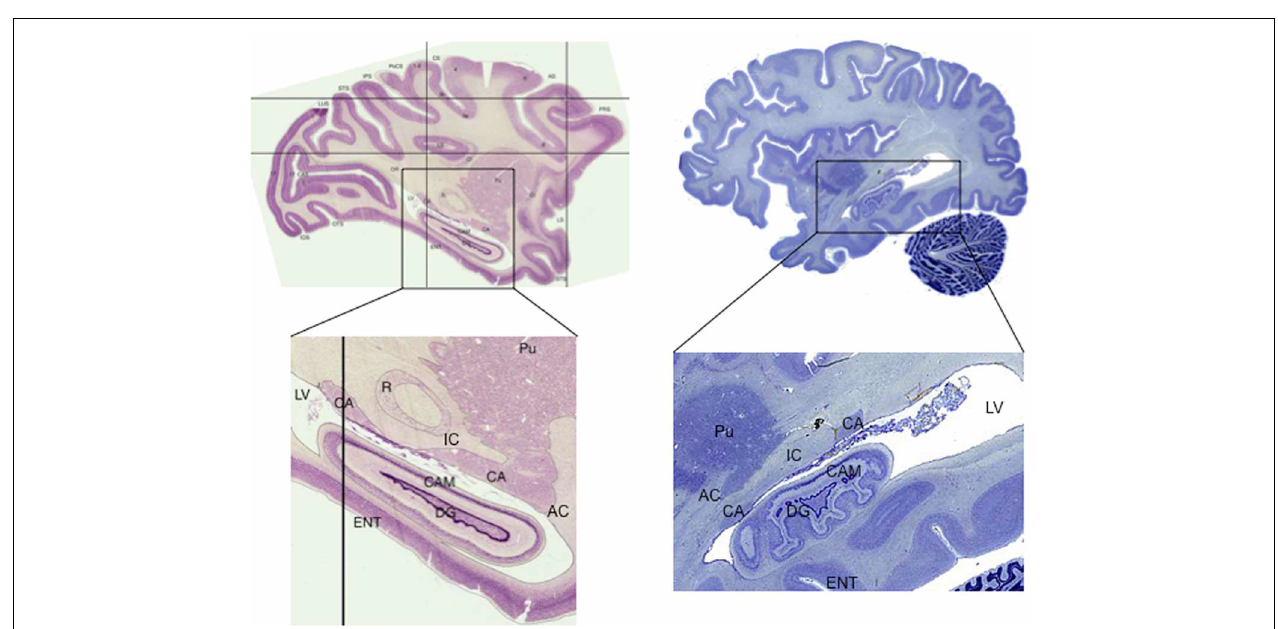
FIGURE 2 | Sagittal sections showing the tail of the caudate in macaque monkey ( Macaca mulatta ) and human. Note the narrow width of the structure, how it follows along the lateral ventricle, and how it passes adjacent to the hippocampus. Macaque images from BrainMaps: An Interactive Multiresolution Brain Atlas; http:// brainmaps . org [retrieved on 9-24-2013]. Human images from